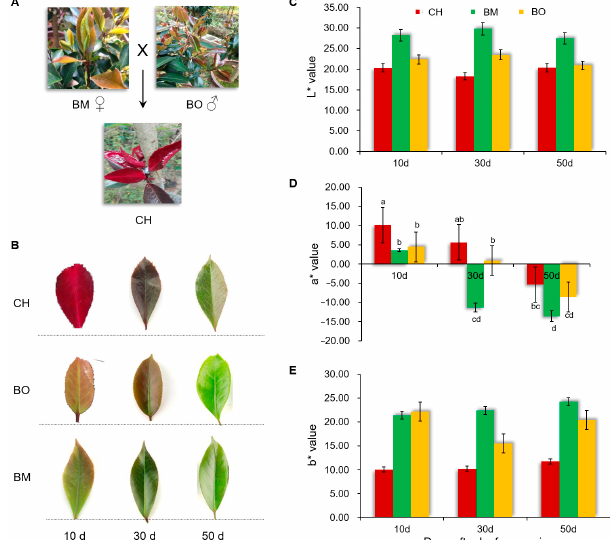
Figure 1. Characterization of leaf color in Camellia japonica cultivars. ( A ) Camellia japonica cv. Chunjiang Hongxia (CH) is the o ff spring of C. japonica cv. Black Magic (BM) as the female parent and C. japonica cv. Black Opal (BO) as the male parent. Representatives of 10-day-old (10 d) leaves of each cultivar are shown. ( B ) Representatives of leaves of CH, BM, and BO cultivars 10 days, 30 days, and 50 days after leaf-expansion. ( C – E ) Leaf color indices of CH, BM, and BO cultivars at di ff erent leaf growth stages. L* ( C ), a* ( D ), and b* ( E ) values were used. L* represents a color range from 0 (black) to 100 (white); a* represents a color range from − 120 (green) to 120 (red); b* represents a color range from − 120 (blue) to 120 (yellow). Data are means ± standard deviation (SD), n = 3. Di ff erent letters above the bars indicate significant di ff erences ( p < 0.05, one-way